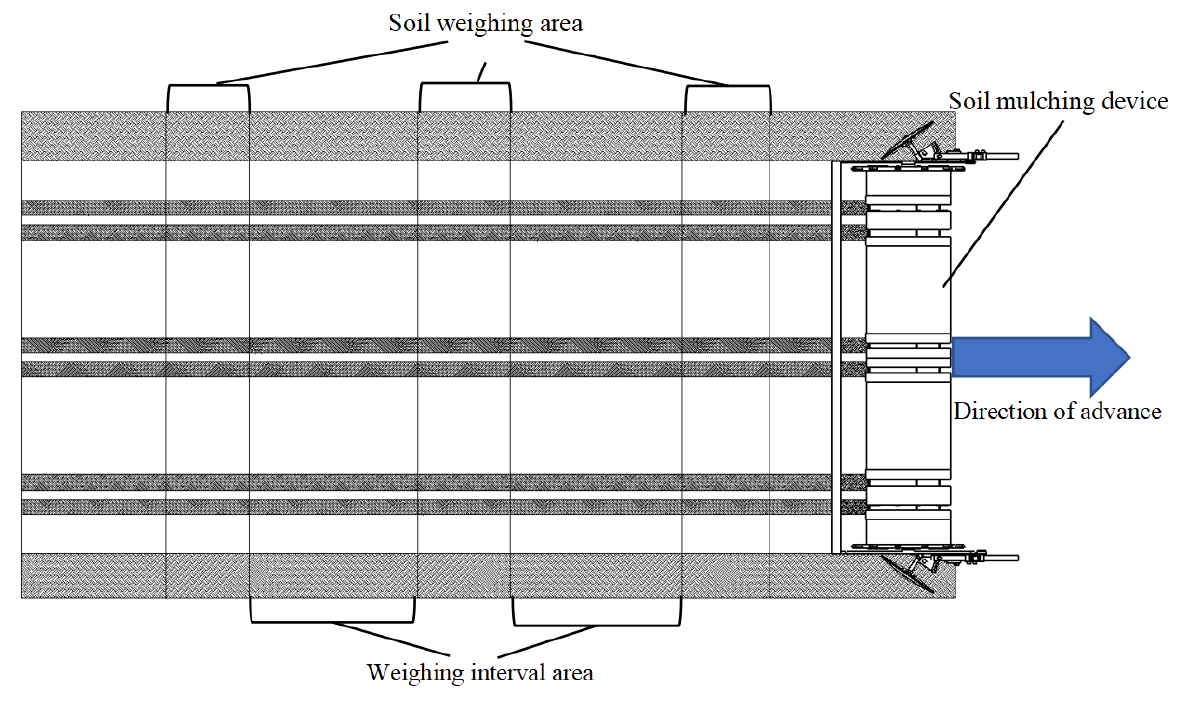
Figure 10. Field test diagram. Table 11. Field experiment design and